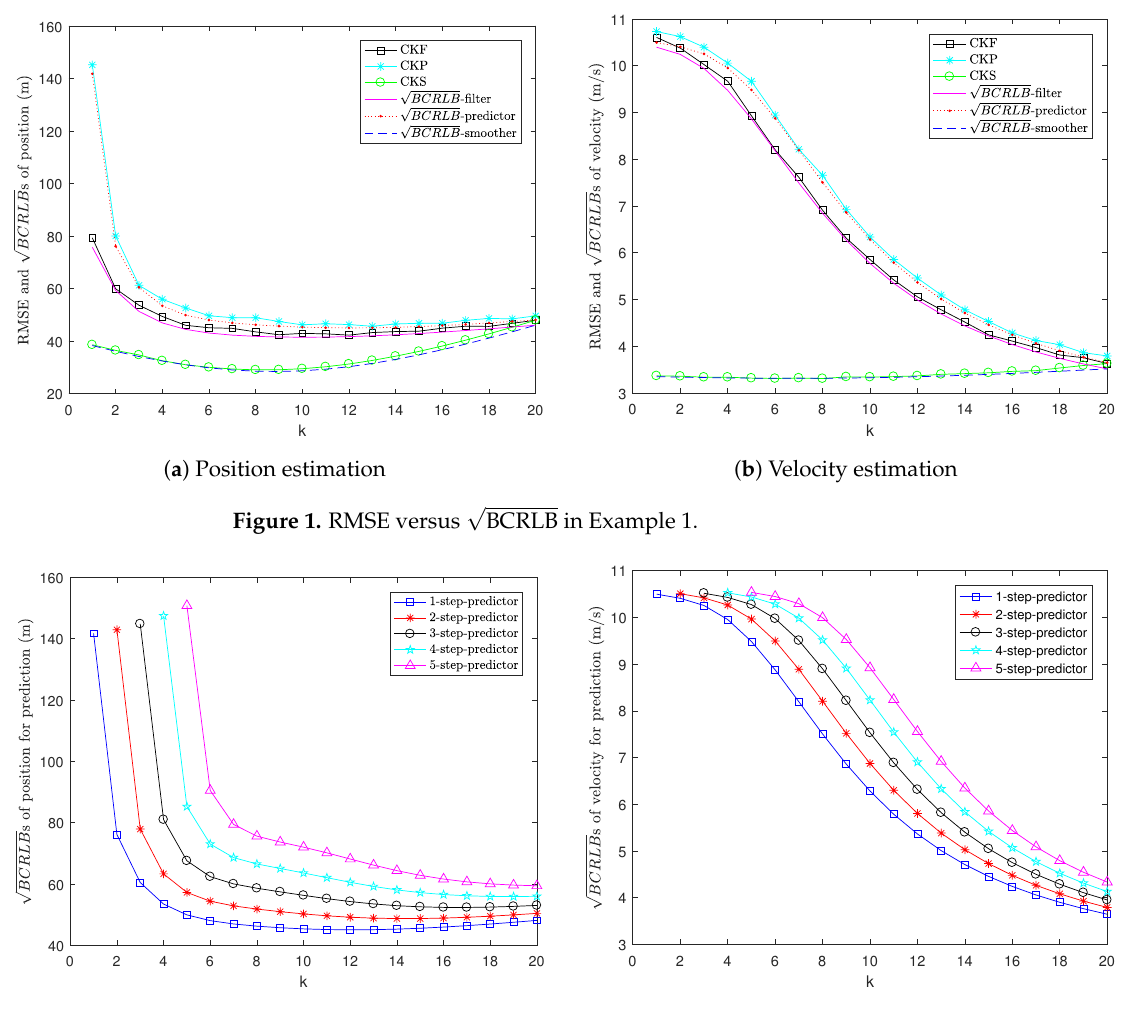
√ Figure 2. BCRLBs for prediction in Example